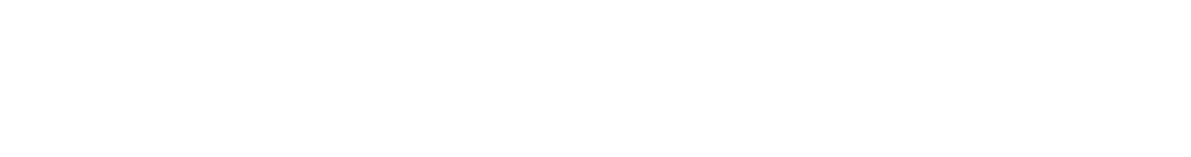
TABLE 2 | FTIR peak assignments of SEO, LiTFSI and SEO/LiTFSI polymer electrolytes and peak shifts at various salt concentrations. Vibration assignment SEO SEO/LiTFSI LiTFSI PS PEO